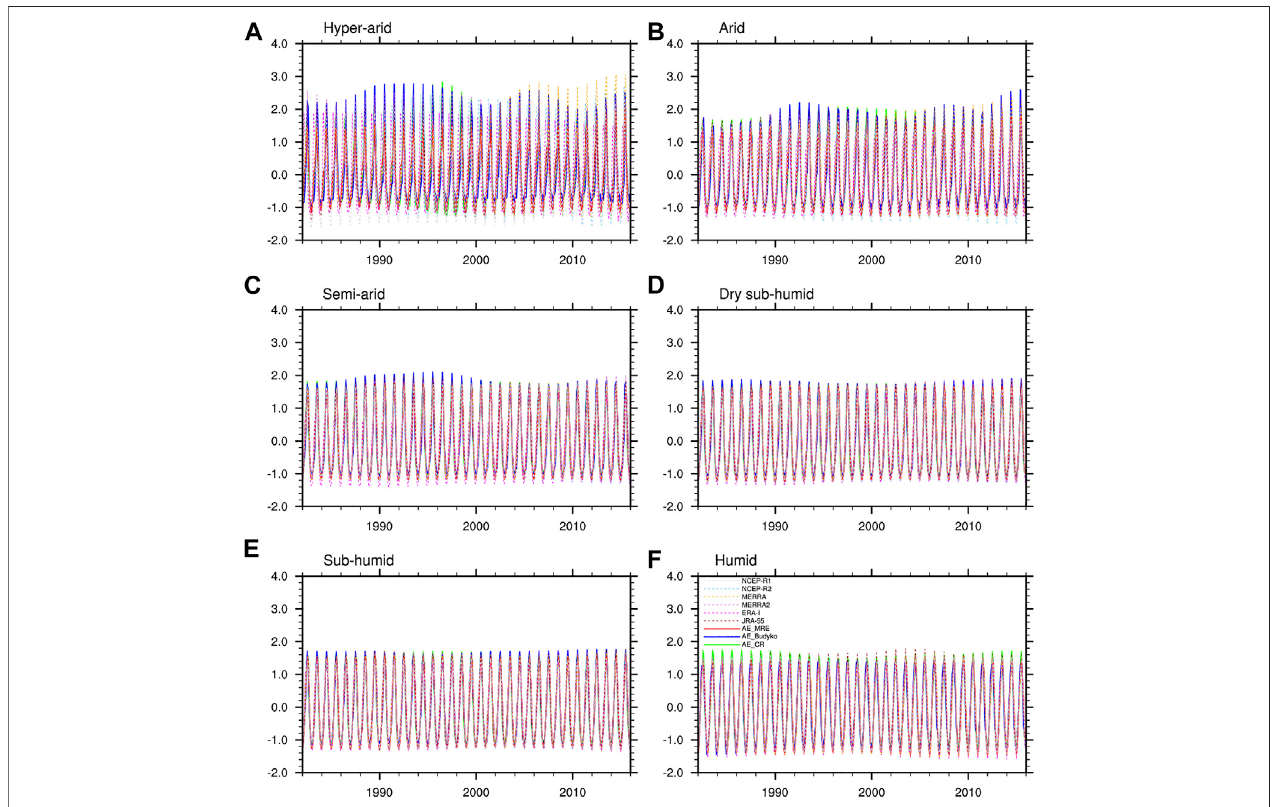
FIGURE 2 | X-12-ARIMA seasonal components ( S t ) of actual evapotranspiration (AE) derived from AE_WAR, AE_CR, AE_Budyko, and reanalyses over the (A) hyper-arid, (B) arid, (C) semi-arid, (D) dry sub-humid, (E) sub-humid, and (F) humid regions.